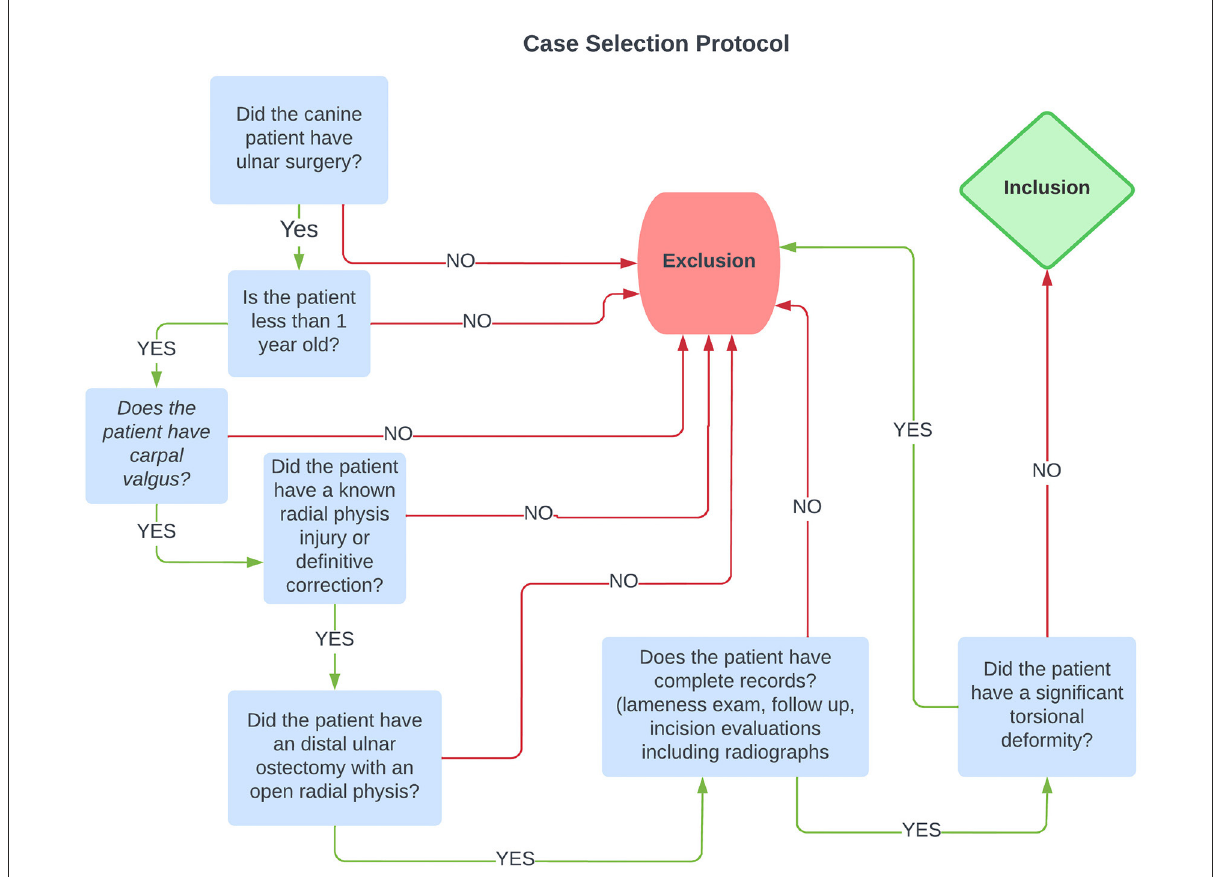
FIGURE1 The case selection process, as described, is shown in flow chart form.